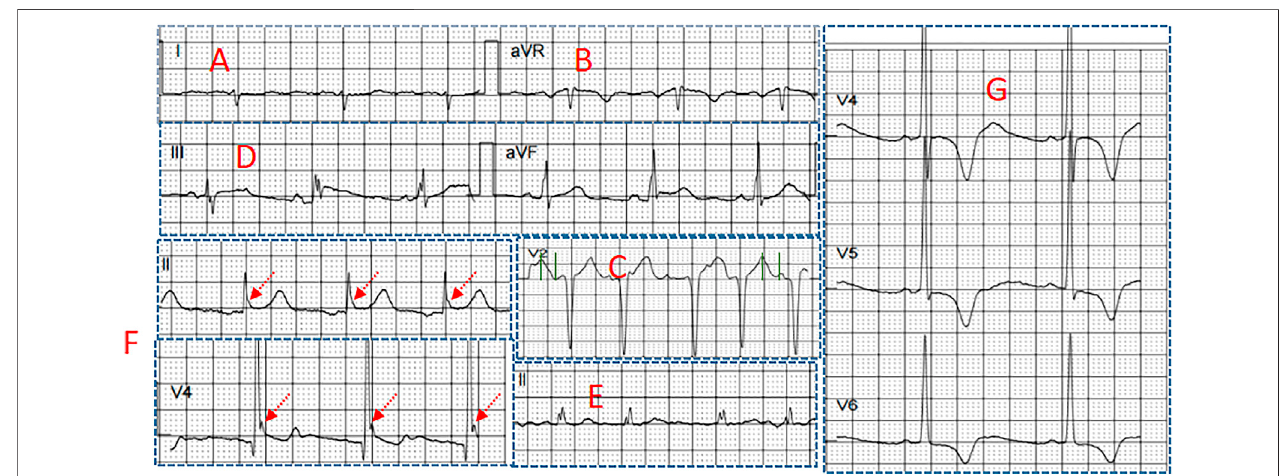
FIGURE 2 | Several electrocardiographic markers for POVA (A) S-wave in lead I (B) R-wave in lead aVR (C) Tpeak-Tend interval in lead V 2 (D) Combination of fragmented QRS and J wave (E) fragmented QRS (F) J wave in the inferior leads, and (G) S V1 +R V5 > 35 mm.